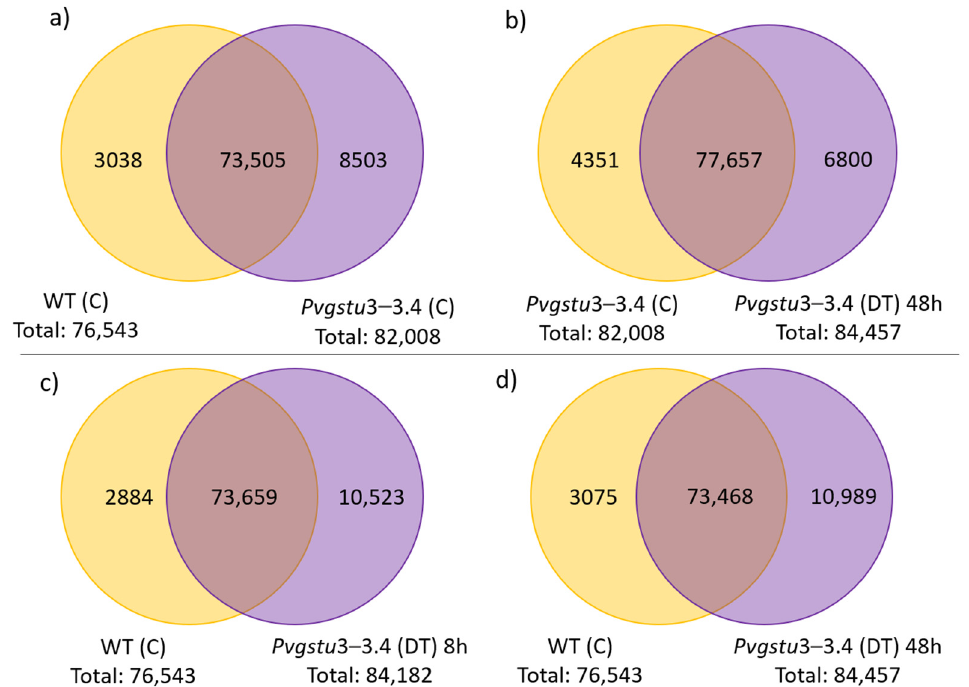
Figure 4. Venn diagram of differentially expressed genes (DEGs). Comparison between ( a ) WT vs. Pvgstu3–3.4 in stress-free control (C) conditions (groups 1 vs. 2, respectively); ( b ) stress-free Pvgstu3–3.4 (C) vs. Pvgstu3–3.4 at 48 h under DT (groups 2 vs. 4, respectively); ( c ) stress-free WT (C) vs. Pvgstu3–3.4 at 8 h under DT (groups 1 vs. 3, respectively); and ( d ) stress-free WT (C) vs. Pvgstu3–3.4 under 48 h DT (groups 1 vs. 4, respectively). The intersection of the two circles represents overlapping DEGs between the representative datasets.